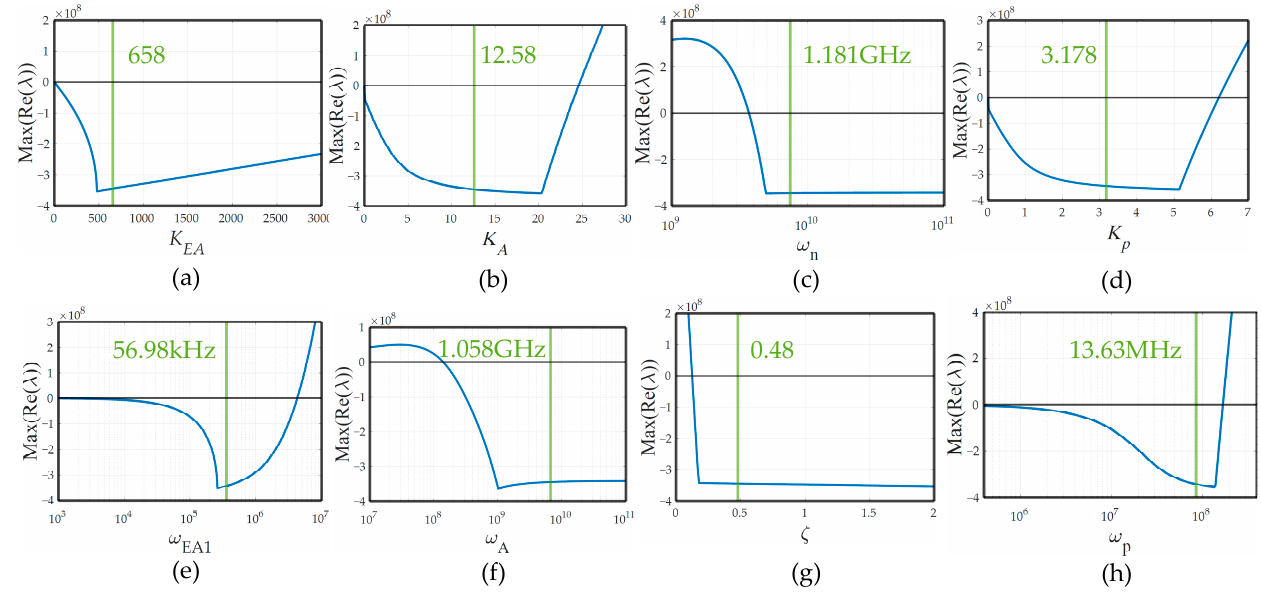
Figure 8. Parameter sensitivity simulation result for ( a ) the voltage gain of the folded cascode EA, ( b ) the voltage gain of the FVF stage, ( c ) the natural frequency of SSF, ( d ) the voltage gain of the pass transistor, ( e ) the dominant pole at the folded cascode EA, ( f ) the pole at the FVF stage, ( g ) the damping factor of SSF, ( h ) the pole at the output.